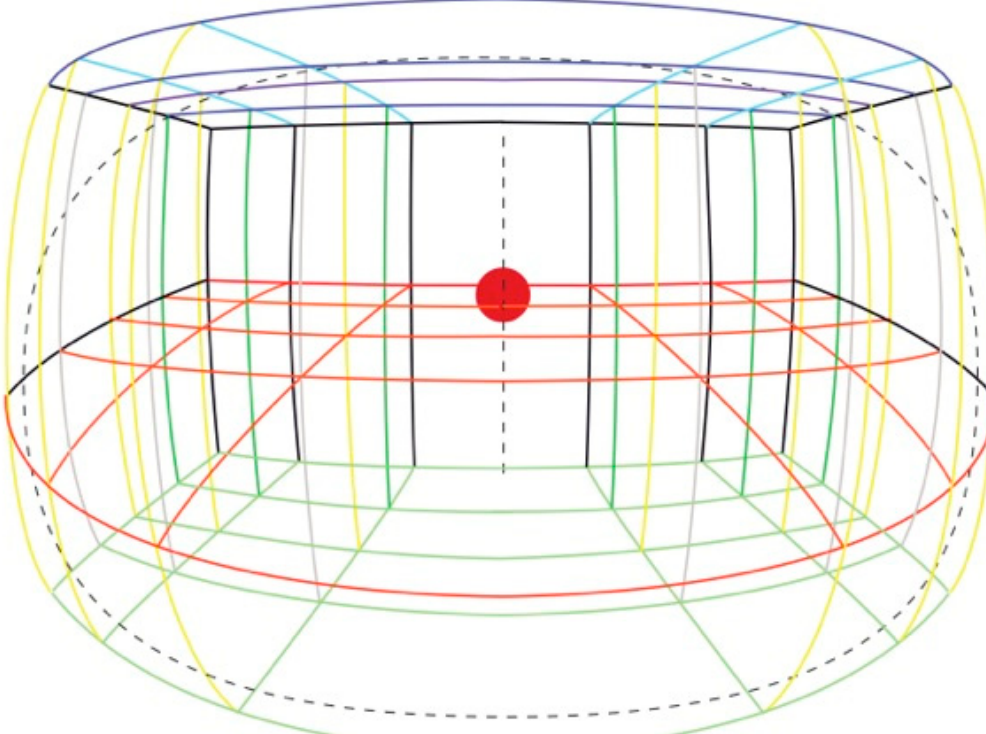
Figure 5. Natural perspective depiction of the 3D grid room. This is a drawing by one of the authors of the subjective visual experience of the experimental space based on a fixation point at the red ball. The drawing is a synthesis of both eye views, and the dotted elliptical line shows the approximate limits of the visual field, as judged from observation by the artist, which in this case is around 150 degrees on the horizontal axis and 90 degrees on the vertical axis.